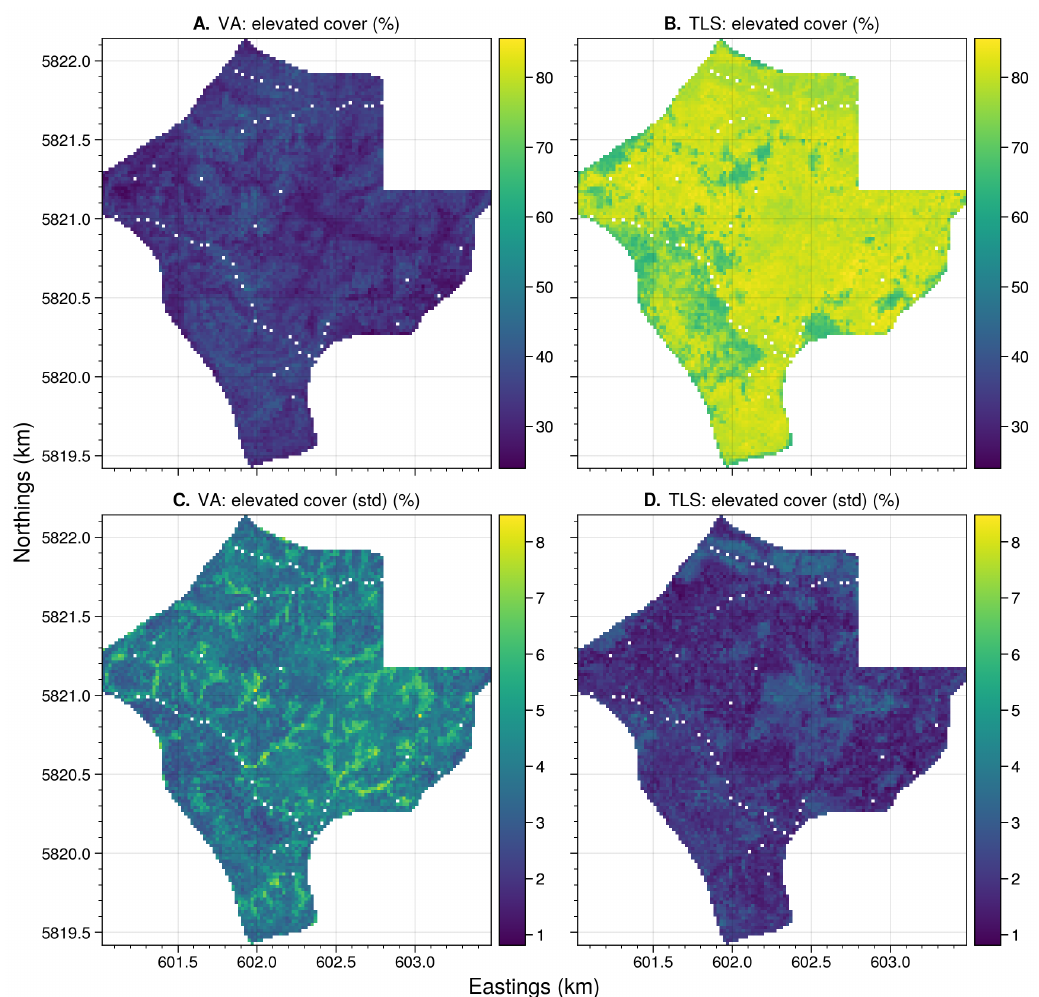
Figure A17. The mean and standard deviation of landscape-level predictions for elevated fuel cover using visual assessments ( A , C ) and TLS ( B , D ) at